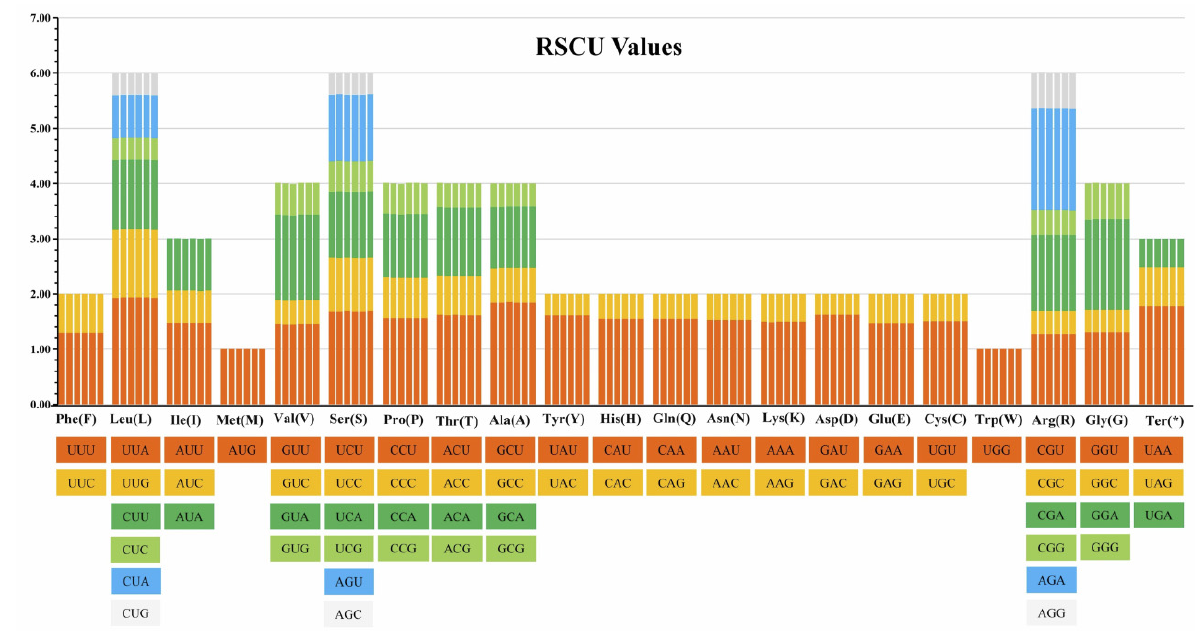
Figure 4. Comparative analysis plots of RSCU values for the six Pyracantha chloroplast genomes. Each amino acid corresponds to six histograms, and their heights represent the RSCU value. The histograms from left to right are P. atalantioides , P. angustifolia , P. coccinea , P. fortuneana (red), P. fortuneana -1 (white), and P. fortuneana -2 (white). The three P. fortuneana chloroplast genomes (one accession with the red flower